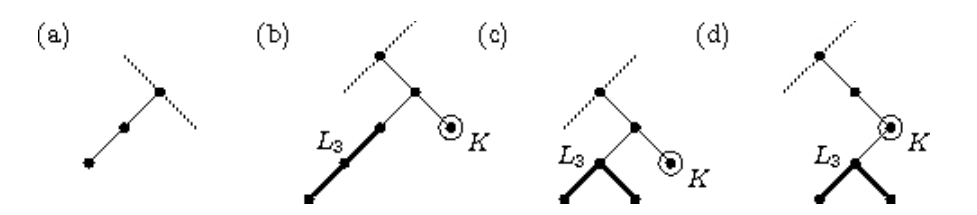
Fig. 1: ( a ) a tree containing a pendant P 2 path, ( b ) choice of path L 3 and vertex K for trees with pendant P 3 , ( c ), ( d ) choice of path L 3 and vertex K for trees without pendant paths longer than